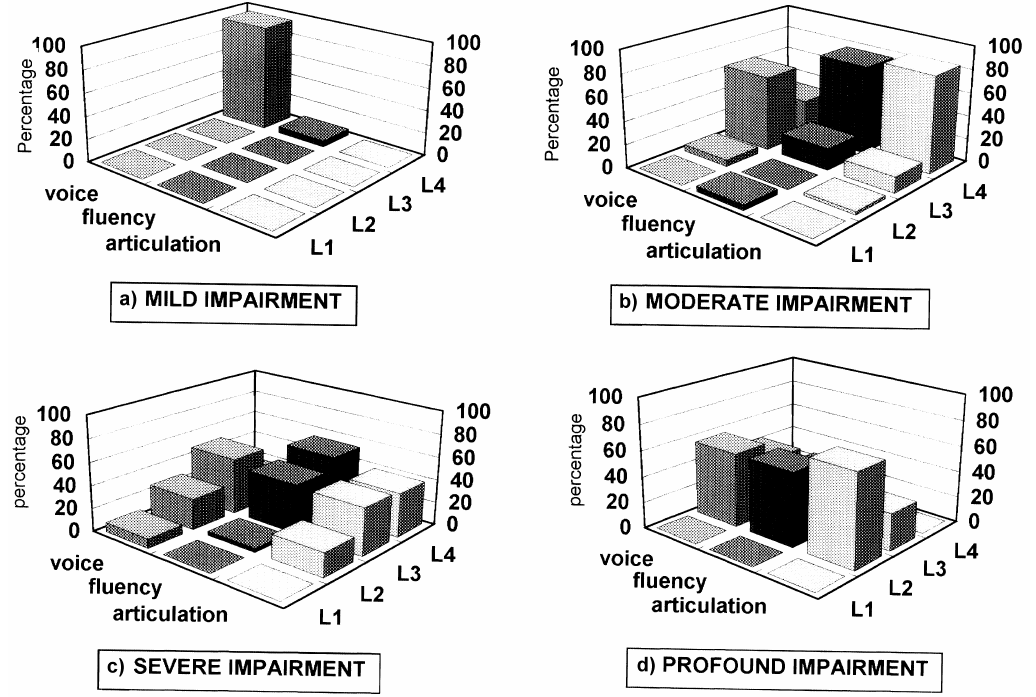
Fig. 2. Percentage of voice, fluency and articulatory impairment according to levels of functional impairment (Level 1 most impaired) for each category of